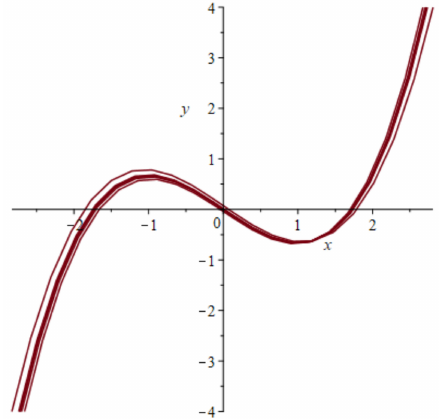
Figure 3. Scaled FHN Nullclines in the phase plane showing two stable points (zero-crossings of the third order Nullcline curve) and one unstable point in the